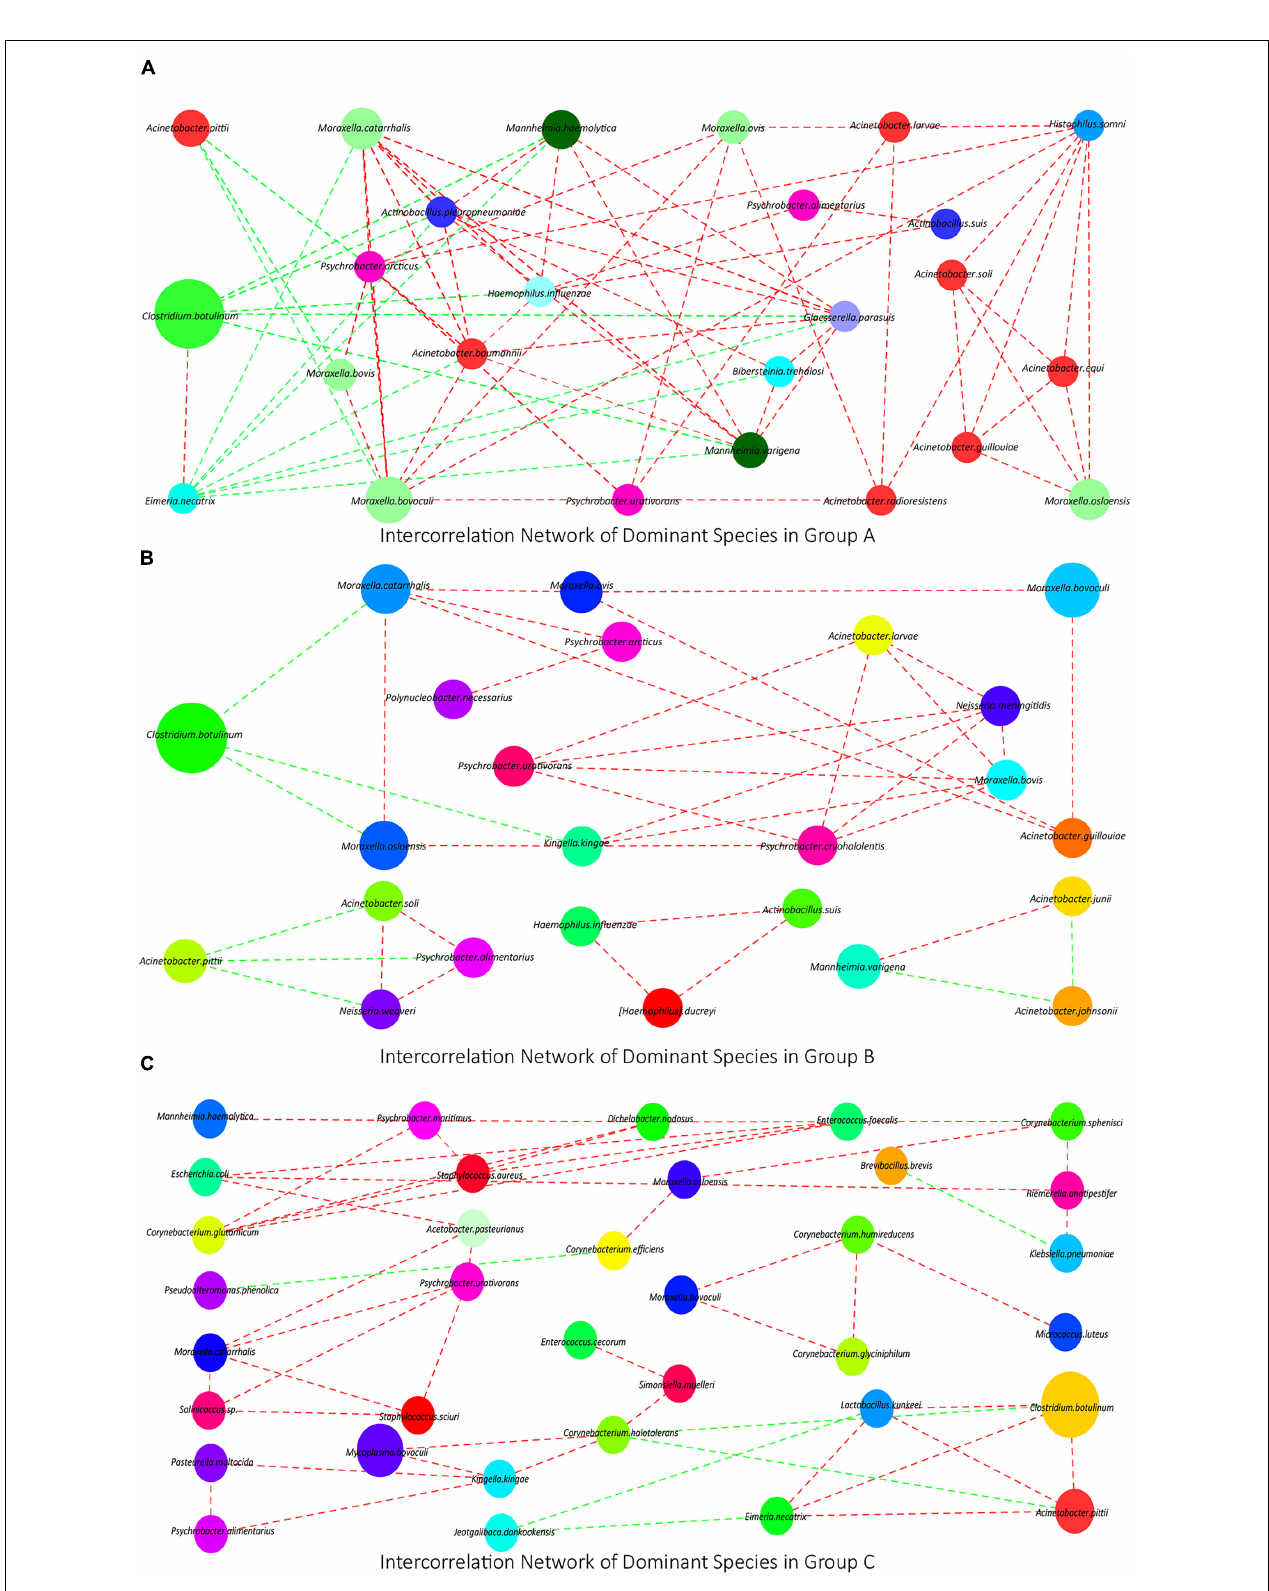
FIGURE 2 | (A–C) The interconnection networks of the top 50 species in groups A, B, and C, respectively. Red lines mean positive correlations, green lines mean negative correlations, and the size of circles represents the relative abundance of the corresponding species.